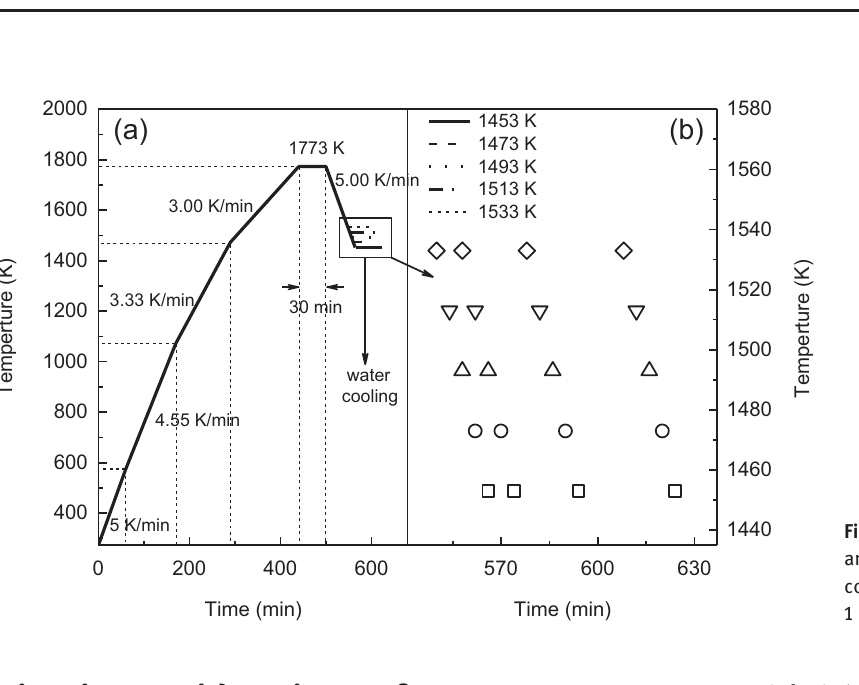
Figure 1: Applied heating schedule from ambient temperature to 1773 K and cooling schedule for slag samples of No. 1 to No. 5 test-run